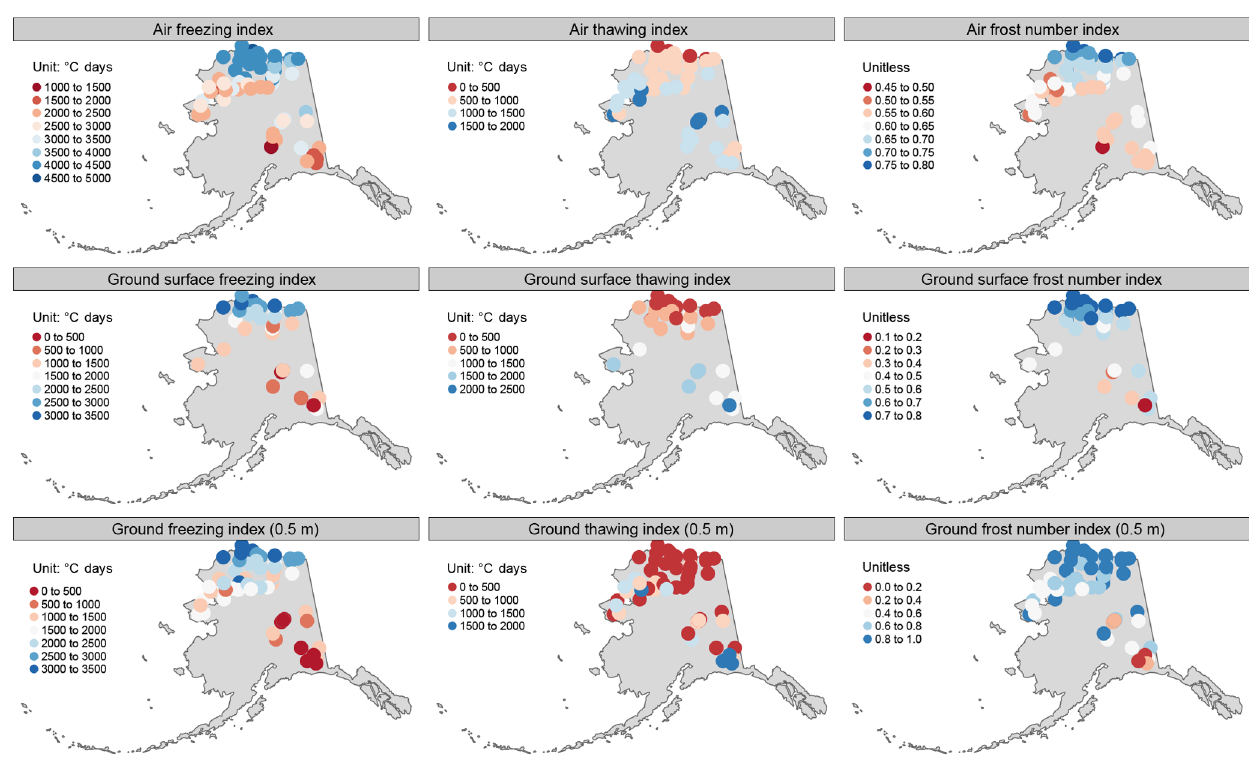
Figure 6. Overview of spatial distribution of freezing–thawing index from air, ground surface temperature, and ground temperature at 0.50m. Frost number (FN) was derived from the freezing–thawing index according to Nelson and Outcalt